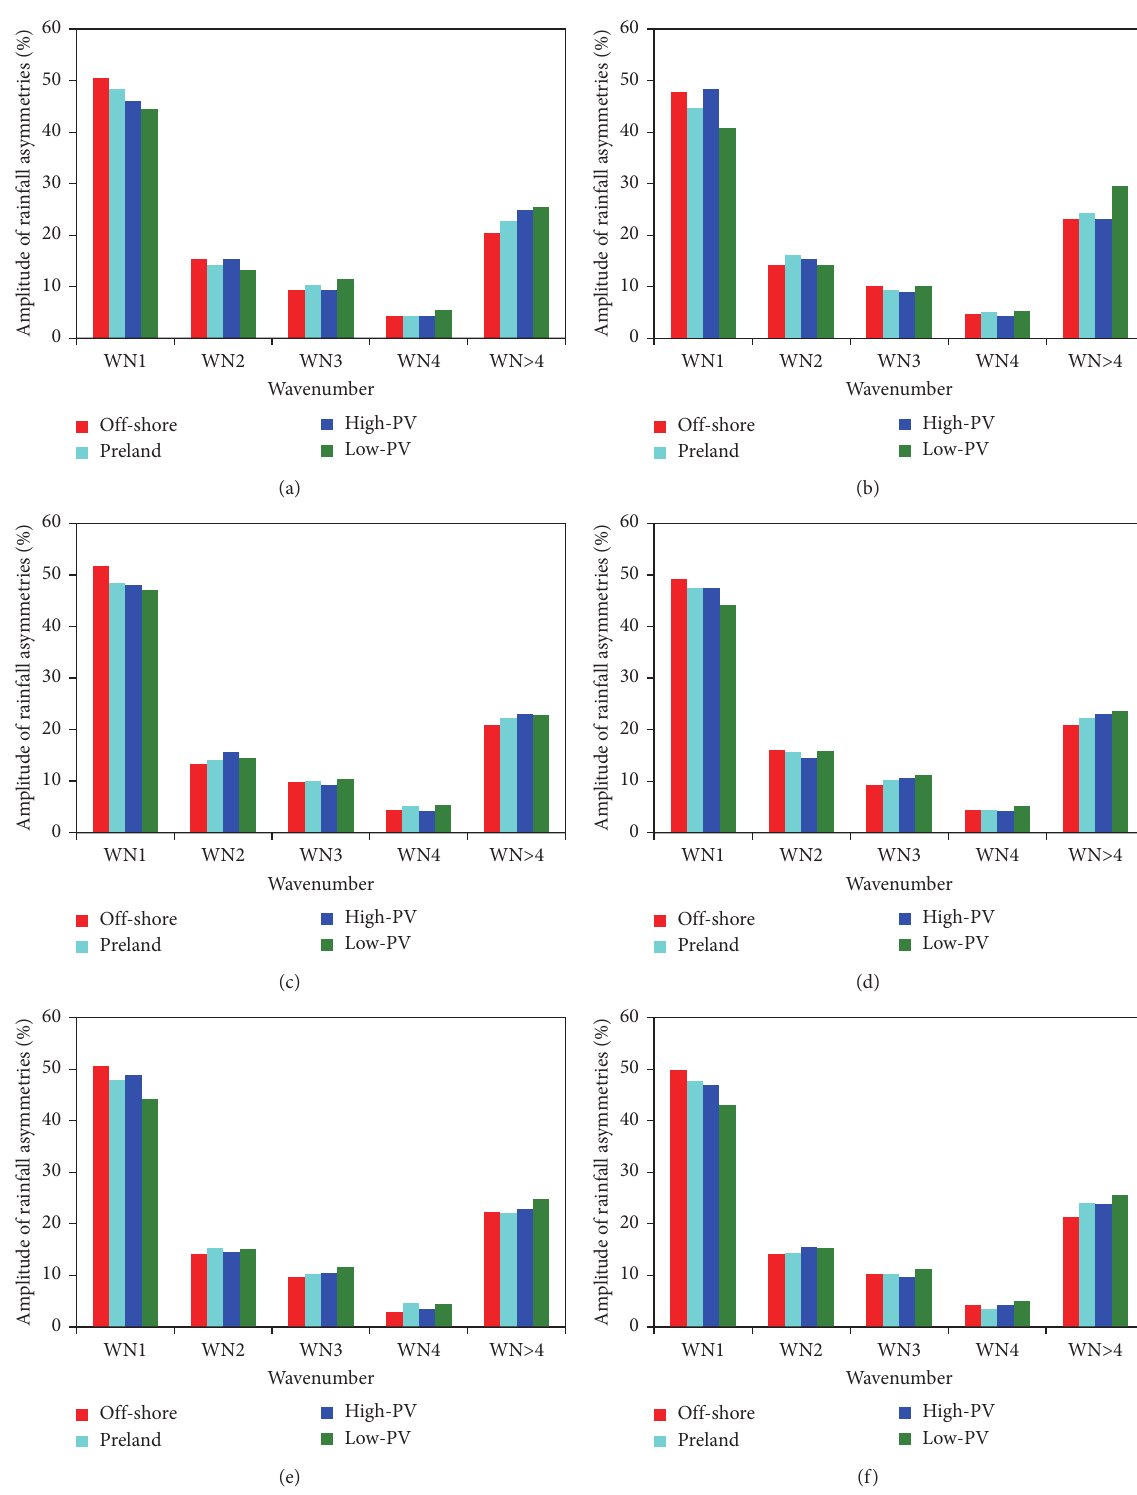
Figure 2: The amplitudes of wavenumbers 1, 2, 3, 4, and 5 asymmetric components of rain rate relative to the total rain rates over the annulus from 30 to 300km from the TC center for (a) ATL, (b) EPA, (c) NWP, (d) NIO, (e) SIO, and (f) SPA basins during the off-shore, preland, and in-land under high-PV and low-PV